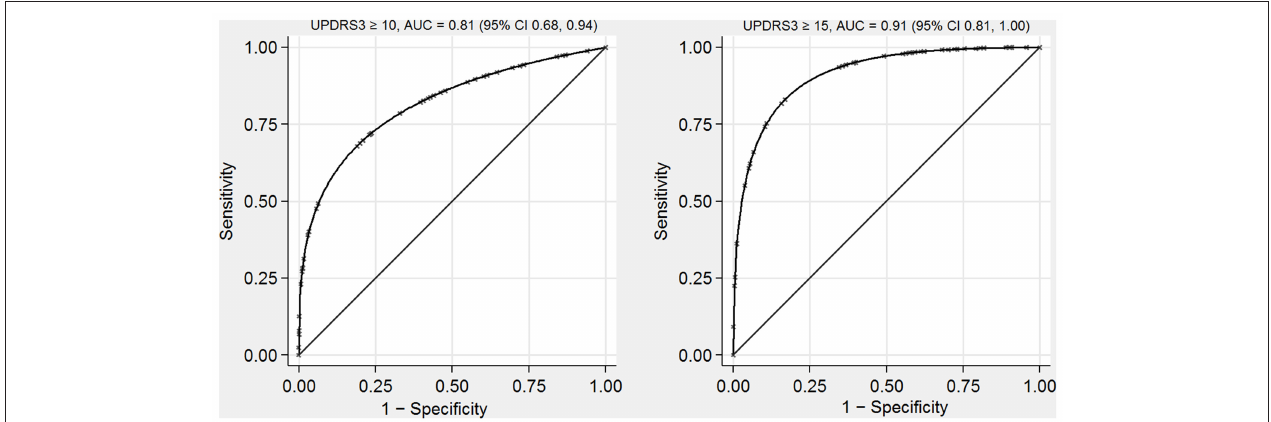
FIGURE 2 | Receiver operating characteristic curves for identifying individuals with UPDRS3 ≥ 10 and UPDRS3 ≥ 15 in a population-based sample with environmental Mn exposure, South Africa, 2016–2020. The AUCs indicate that the UPDRS3 predictive model performed well. AUC, area under the receiver operating characteristic curve; UPDRS3, Unified Parkinson’s Disease Rating Scale motor subsection 3; Mn,